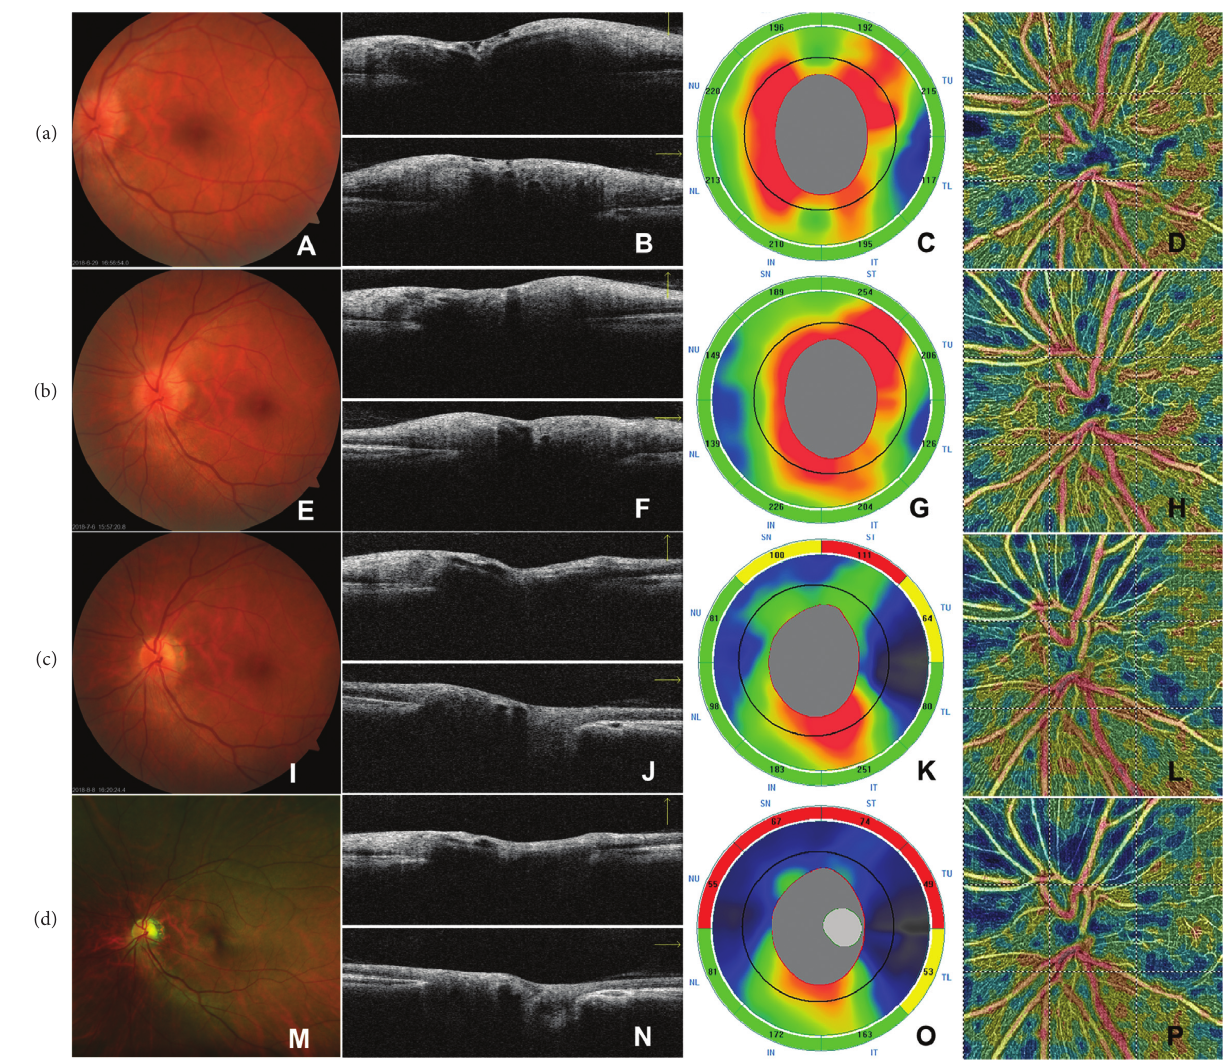
Figure 1: The time course of CFP, structural OCT, and Angio-OCT (OCT-A) findings in ONH in a case with NAION ((a) baseline: A ∼ D, (b) 1 ∼ 2w: E ∼ H, (c) 1 ∼ 2m: I ∼ L, and (d) 3 ∼ 6m: M ∼ P). At presentation, CFP (A, E, I, M) indicated the occurrence of ODE at the initial visit (A), and the subsequent resolution (E, I) of ODE and the final pallor of optic disc (M). The B-scan OCT image of ONH (B, F, J, N; above, horizontal B-scan; bottom, vertical B-scan) showed that, at the initial diagnosis (B), there was edema of the optic disc and RNFL, which gradually subsided with the progress of the disease (F, J, N), and the RNFL around the upper optic disc became significantly thinner at 3–6M (N). The RNFL thickness map (C, G, K, O) showed that the thickness of the RNFL at the initial visit (C) and 1 ∼ 2w (G) follow-up significantly increased, which were followed by gradual decrease at 1 ∼ 2m (K) and 3 ∼ 6m (O) follow-ups, especially those in the superior sector, as the increasing areas of red or yellow color shown in the map. The vessel density map of Angio-Disc (D, H, L, P) showed an superiorly sectoral reduction of the vessel density of the RPC from the acute stage (D, H) to the late stage (L, P) of NAION, as the increasing areas of blue color shown in the map. CFP, color fundus photography. ONH, optical nerve head. NAION, nonarteritic anterior ischemic optic neuropathy. ODE, optic disc edema. RNFL, retinal nerve fiber layer. RPC, radial peripapillary